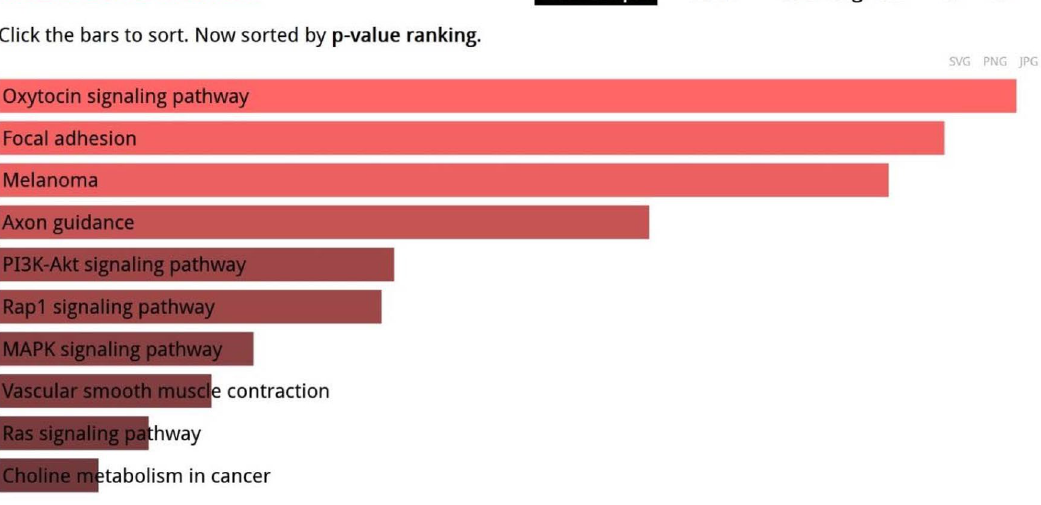
Figure 2. KEGG pathways of the enriched pathways of the down-regulated genes 11 .